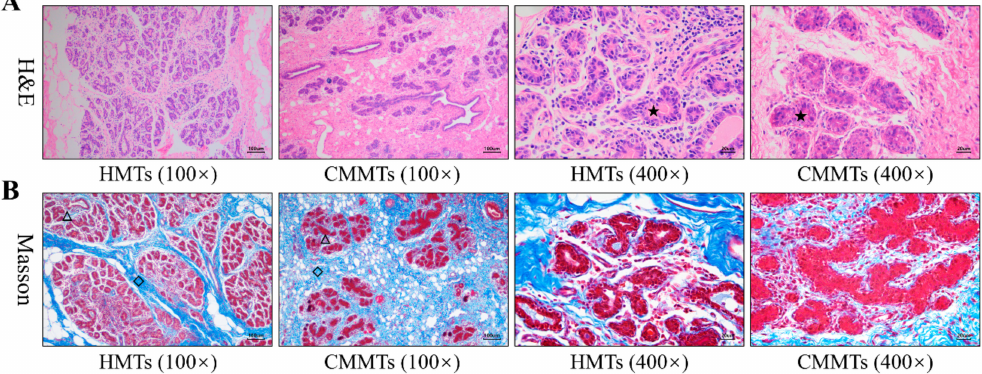
Figure 1. Morphological comparisons of mammary tissues from HMTs and CMMTs disease symptoms. ( A ) H&E staining; ( B ) Masson staining. The pentagram denotes mammary acinus, diamond